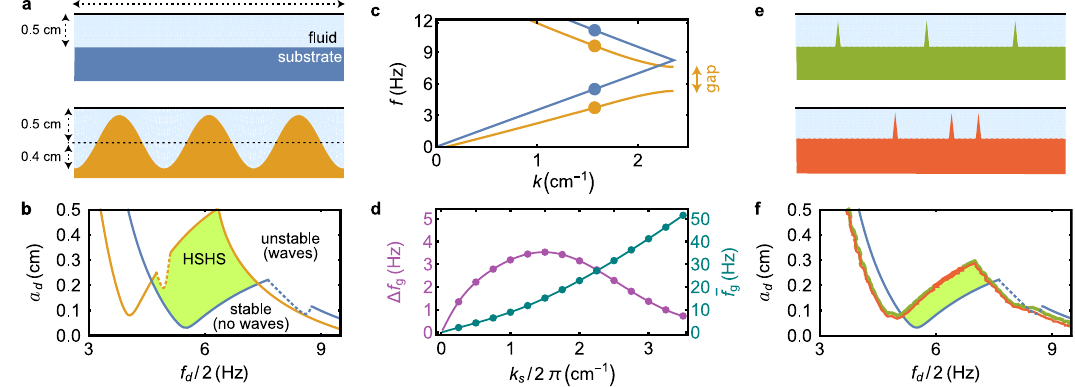
Fig. 3 Faraday instabilities in one dimension with periodic boundary conditions. a Flat (blue) and sinusoidal (orange) substrate geometries. b Instability boundaries in the driving amplitude vs. driving frequency space for the color-corresponding substrates in a showing the subharmonic (continuous lines) and harmonic (dotted lines) instability boundaries as well as the resulting HSHS region (shaded area). c Frequency vs. wavenumber in the dispersion relation for the substrates in a (dots) and for the respective in fi nite-length systems (lines). d Frequency gap Δ f g and mean frequency (cid:2) f g of the modes at the band gap as a function of the substrate wavenumber k s , showing wavenumbers that meet periodic boundary requirements for the substrates shown in a (dots). e Substrate geometries with evenly (green) and randomly (red) spaced sharp peaks. f Instability boundaries as in b for the fl at substrate in a and the sharp-peak substrates in e